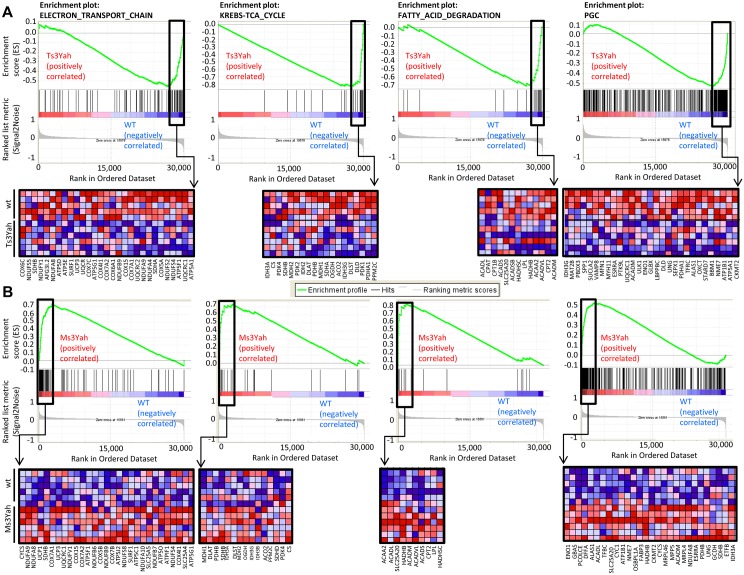
Pathways related to energy metabolism are underexpressed in Ts3Yah skeletal muscles and overexpressed in Ms3Yah skeletal muscles.GSEA-scoring plots of gene expression profile in gastrocnemius muscles from Ts3Yah (A) and Ms3Yah (B) mice. Four plots of representative gene sets relevant to metabolic pathways that were significantly enriched and the ‘PGC’ gene set corresponding to genes involved in OXPHOS that were activated by PGC1-α are shown. The top part of each plot shows the running enrichment score for the gene set as the analysis goes down the ranked list. The middle portion shows the position of members of the gene set in the ranked list of genes. The lower portion plots the value of the ranking metric of the genes in the expression data set. Below the enrichment plots, the corresponding heat maps show the leading edge subsets of genes that contribute most to the enrichment score. The red and blue colours indicate relative expression levels (red: increased expression; blue: decreased expression).